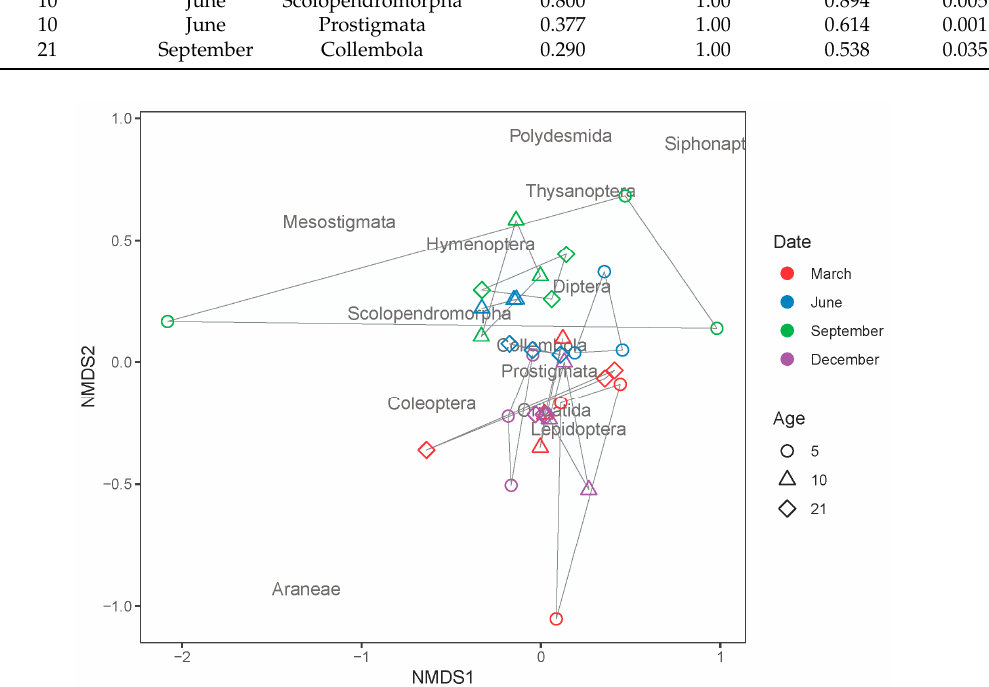
Figure 4. Nonmetric multidimensional scaling ordination (NMDS) showing a two-dimensional representation of the soil arthropod composition. The best NMDS solution was attained at a stress of 0.105. The circles nearest each other in the ordination space have similar assemblages, whereas those located farther apart are less similar.